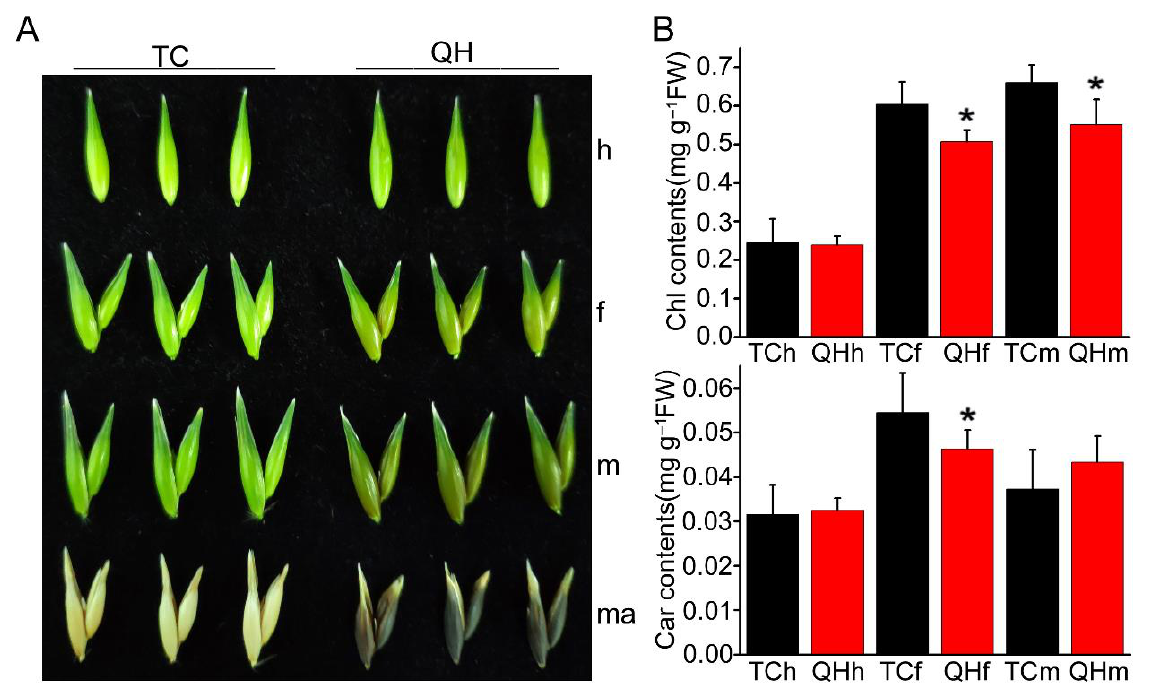
Figure 1. Phenotype identification and photosynthetic pigment content measurement during oat bract development. ( A ) Identification of the phenotype of bracts; TC indicates ‘Triple Crown’; QH indicates ‘Qinghai 444’; h, f, m and ma represent the heading, flowering, milk, and mature stages, respectively. ( B ) The content of photosynthetic pigments in bracts was determined. Bracts at different stages were selected, and the total chlorophyll content and carotenoid content were measured. The asterisk represents a significant difference in total chlorophyll and carotenoid content of ‘Triple Crown’ and ‘Qinghai 444’ bracts (* p < 0.05, Student’s t -test), with 6 replicates.